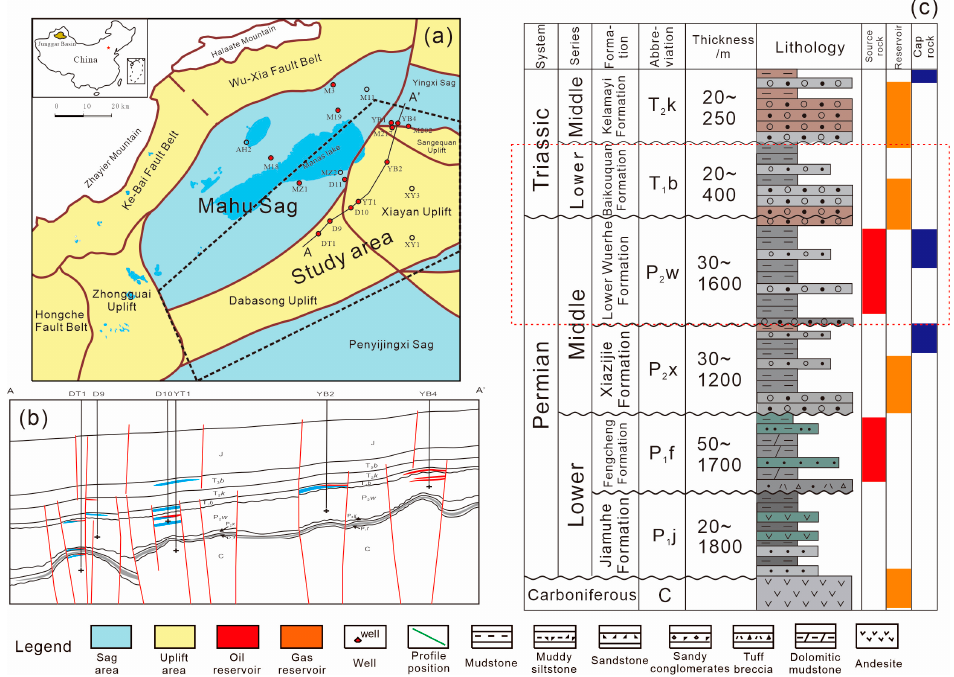
Figure 1. Distribution of structural units in the northwestern Junggar Basin. ( a ) study area tectonic unit and exploration well distribution; ( b ) typical reservoir profile of study area; ( c ) stratigraphy histogram of study area.